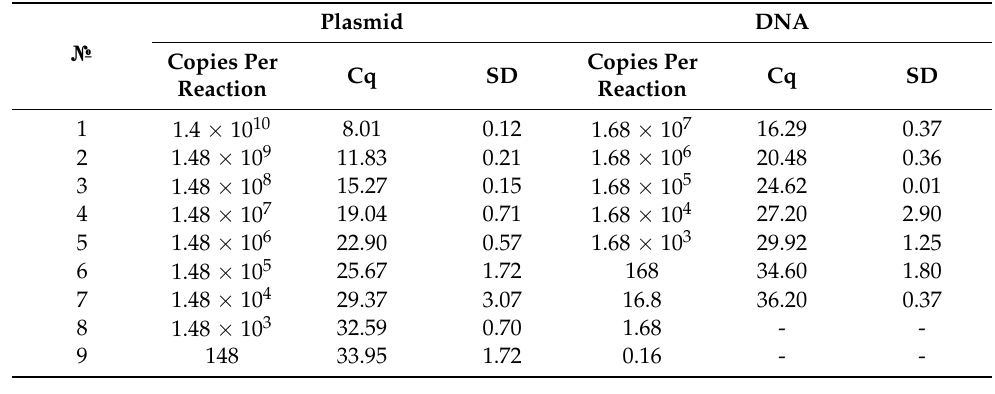
Table 2. Mean Cq values for qPCR carried out on serial dilutions of genomic DNA of the P. parmentieri F149 and corresponding plasmid. SD is standard deviation.